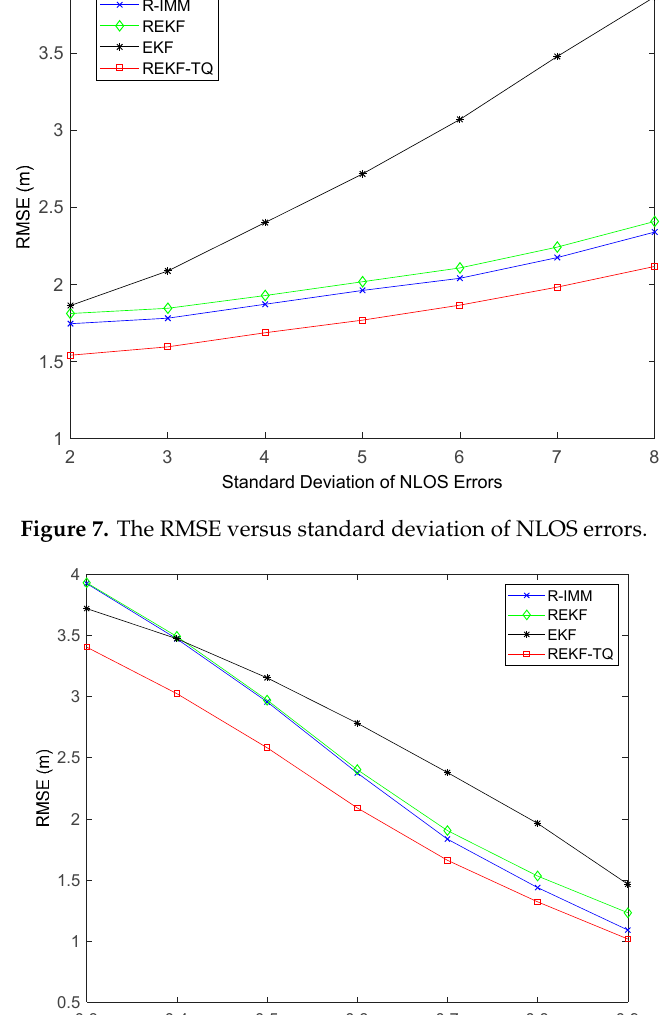
Figure 8. The RMSE versus the probability of LOS propagation.